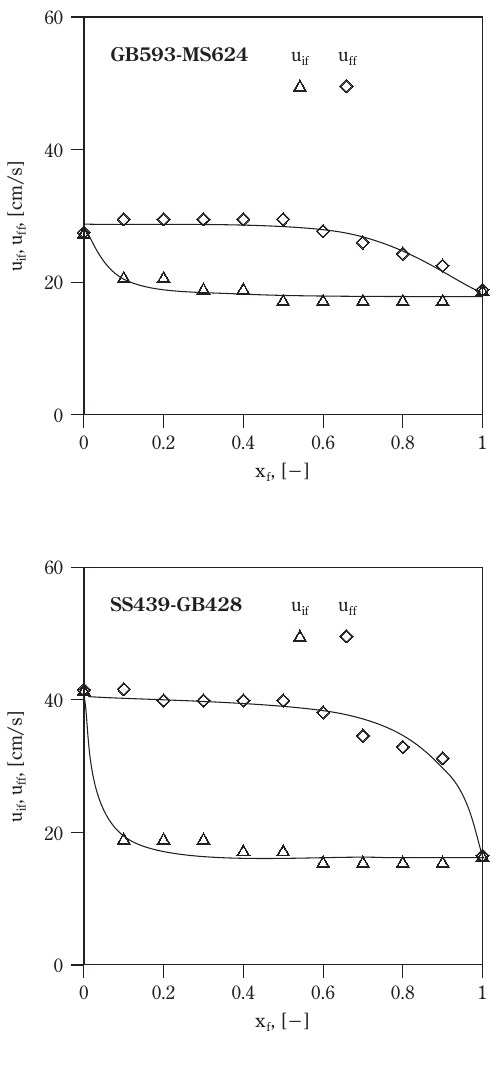
Fig. 7 Fluidization velocity range of density segregating mix- tures. Well-mixed beds.